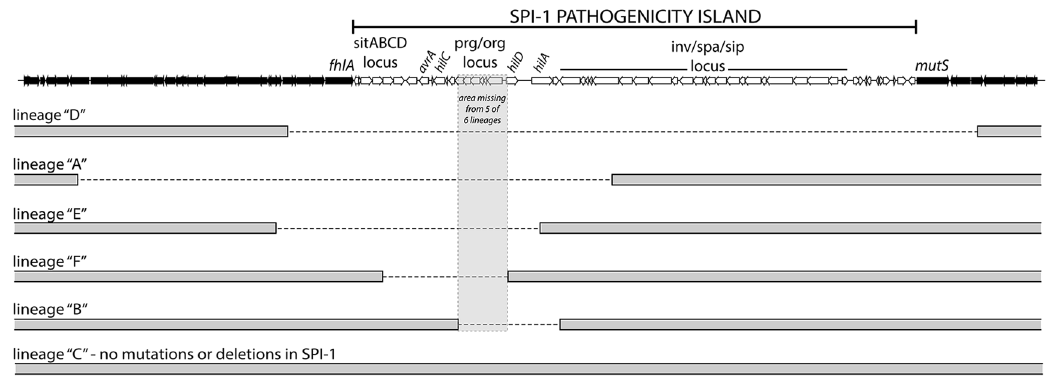
Figure 2. S. Typhimurium hns mutant lineages acquired large chromosomal deletions in the SPI-1 invasion locus. Throughout the 30- day evolution period, 5 out 6 D hns lineages incurred 10–50 kb deletions in SPI-1. The lineages are arranged according to the size of the deletion they incurred. The deleted regions are marked with a dashed line. The grey box encompasses a region common to all five deletions that encoded the prg/ org locus and the promoter and start codon of hilD . Lineage C did not acquire a deletion or any other mutations in the SPI-1